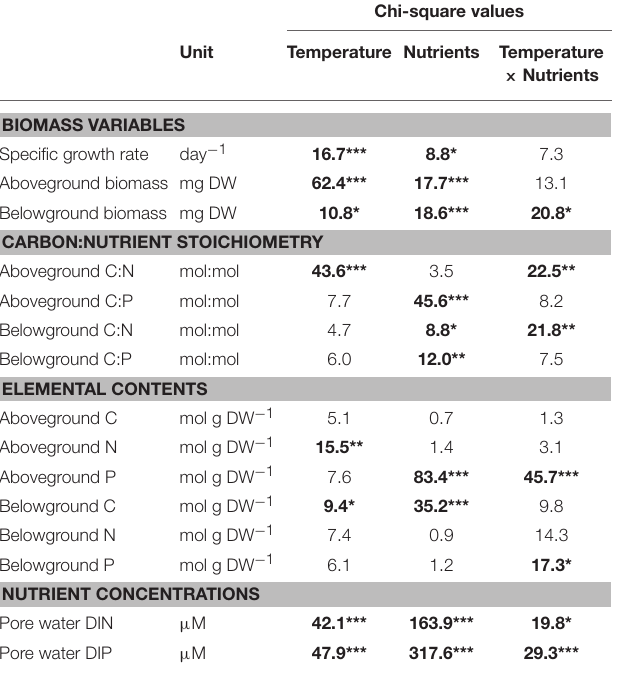
TABLE 1 | Summary of generalized linear model analysis of the Elodea experiment, describing the effect of temperature treatment, nutrient treatment and their interaction on the biomass, carbon:nutrient stoichiometry and elemental contents of Elodea nuttallii and nutrient concentrations.